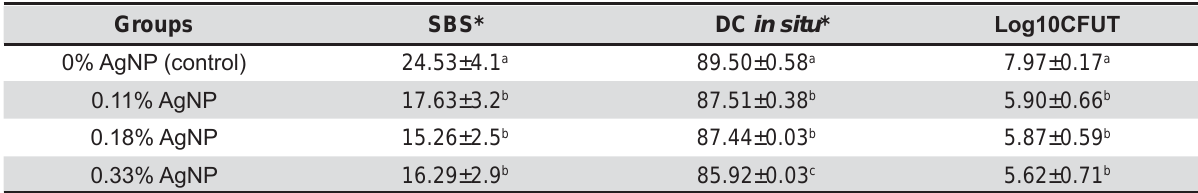
Table 1- Mean and standard deviation of shear bond strength (SBS), degree of conversion (DC) in situ and antimicrobial activity against S. mutans of different silver concentrations